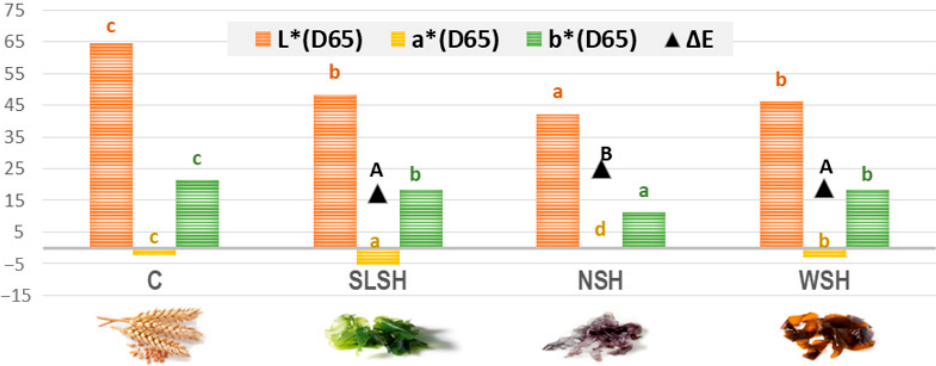
Figure 3. Color parameters in different types of pasta. C: control; SLSH: sea lettuce shiitake pasta; NSH: nori shiitake pasta; WSH wakame shiitake pasta. Different letters indicate significant differences ( p < 0.05) among all the pastas for each parameter.